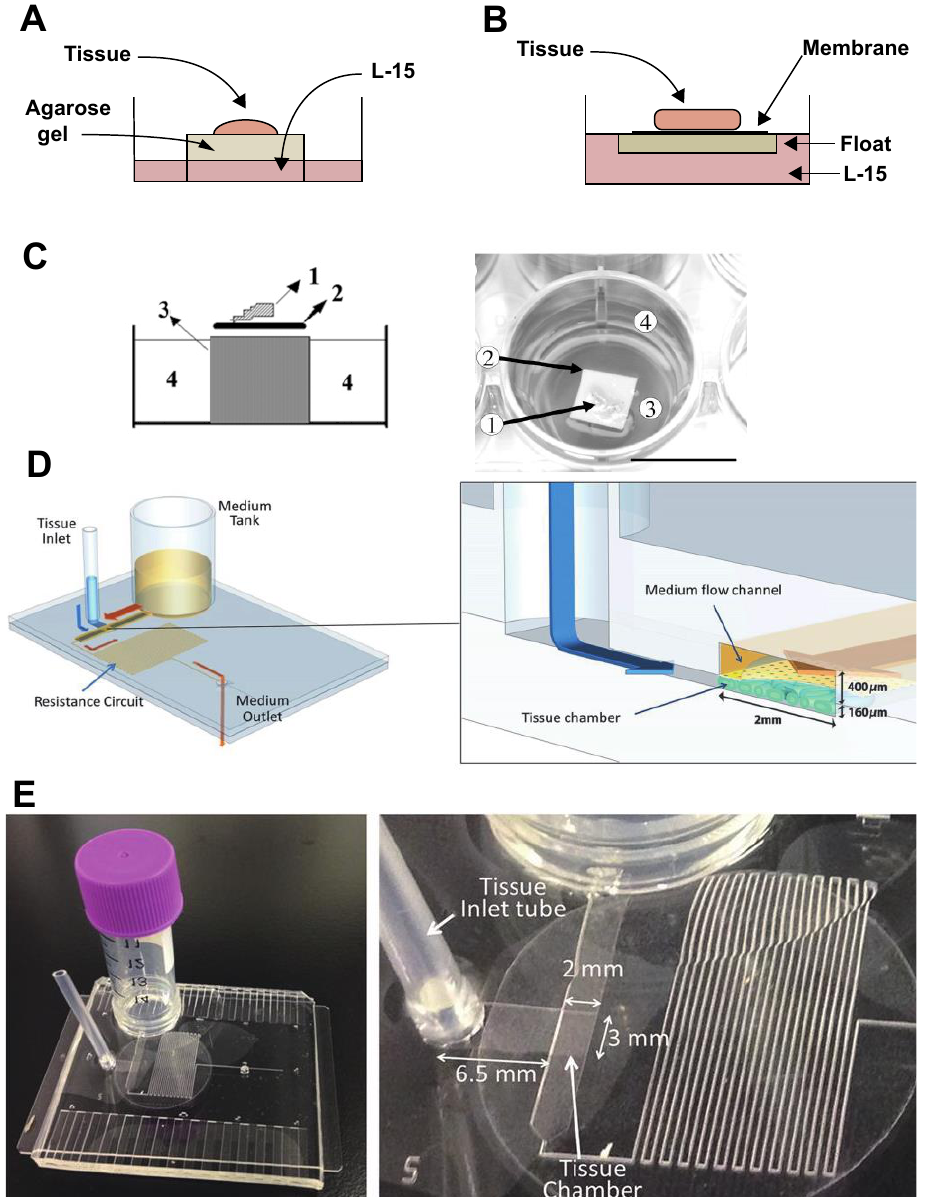
Figure 7. Organ culture systems. ( A ) The classical agarose gel model in mammals [203]; ( B ) the Japanese eel testis culture model [207]; ( C ) the zebrafish testis primary culture model [208] (1, testis tissue; 2, nitrocellulose membrane; 3, agarose cylinder; 4, medium (1 mL); scale bar: 1 cm); ( D ) Microfluid culture model [209]. ( E ) Pumpless microfluid culture [209].